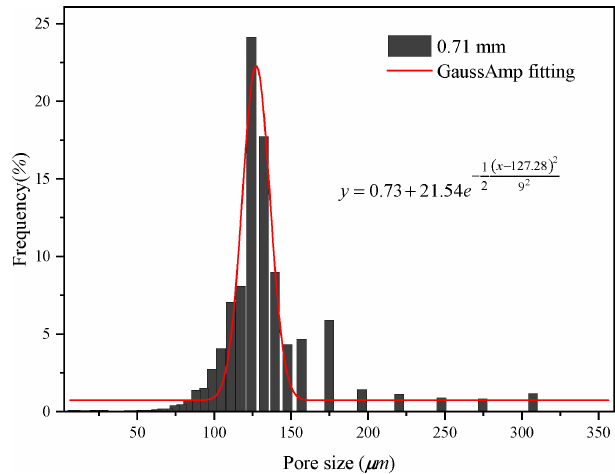
Figure 8. Histogram of the pore size distribution of the permeable stone with a particle diameter of 0.71mm.